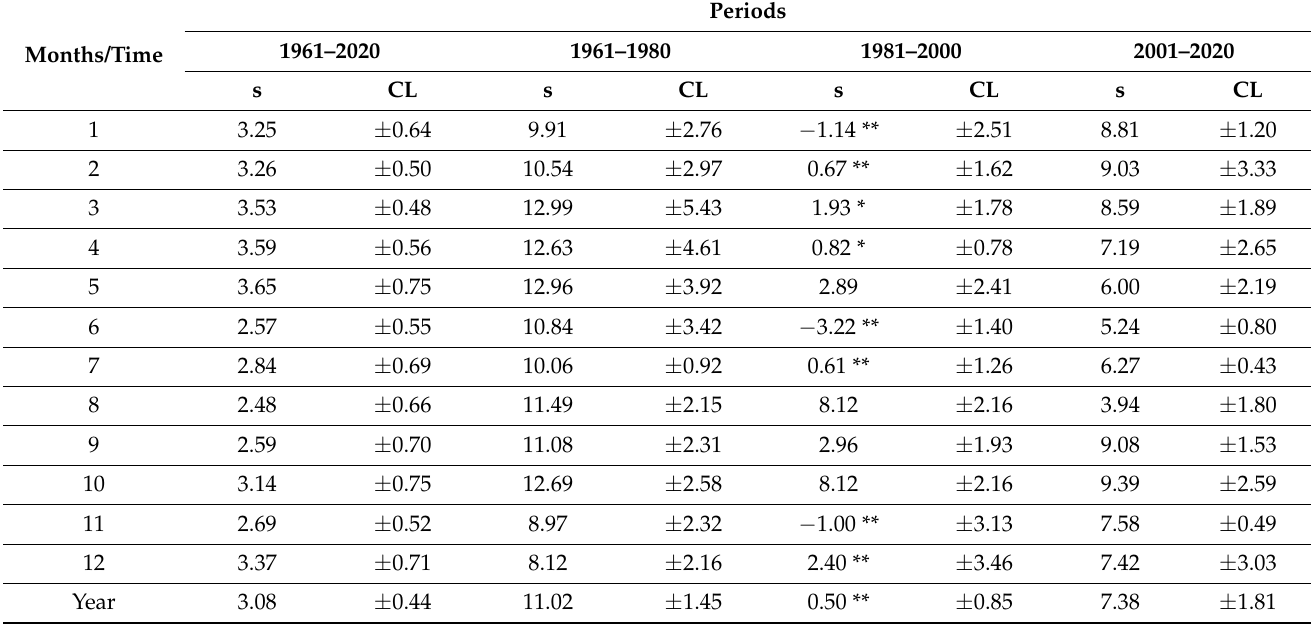
Table 2. Trend analysis of SLR (mm/year) in the Hon Dau station using the ITA (s: slope, and CL: confidence limit, in